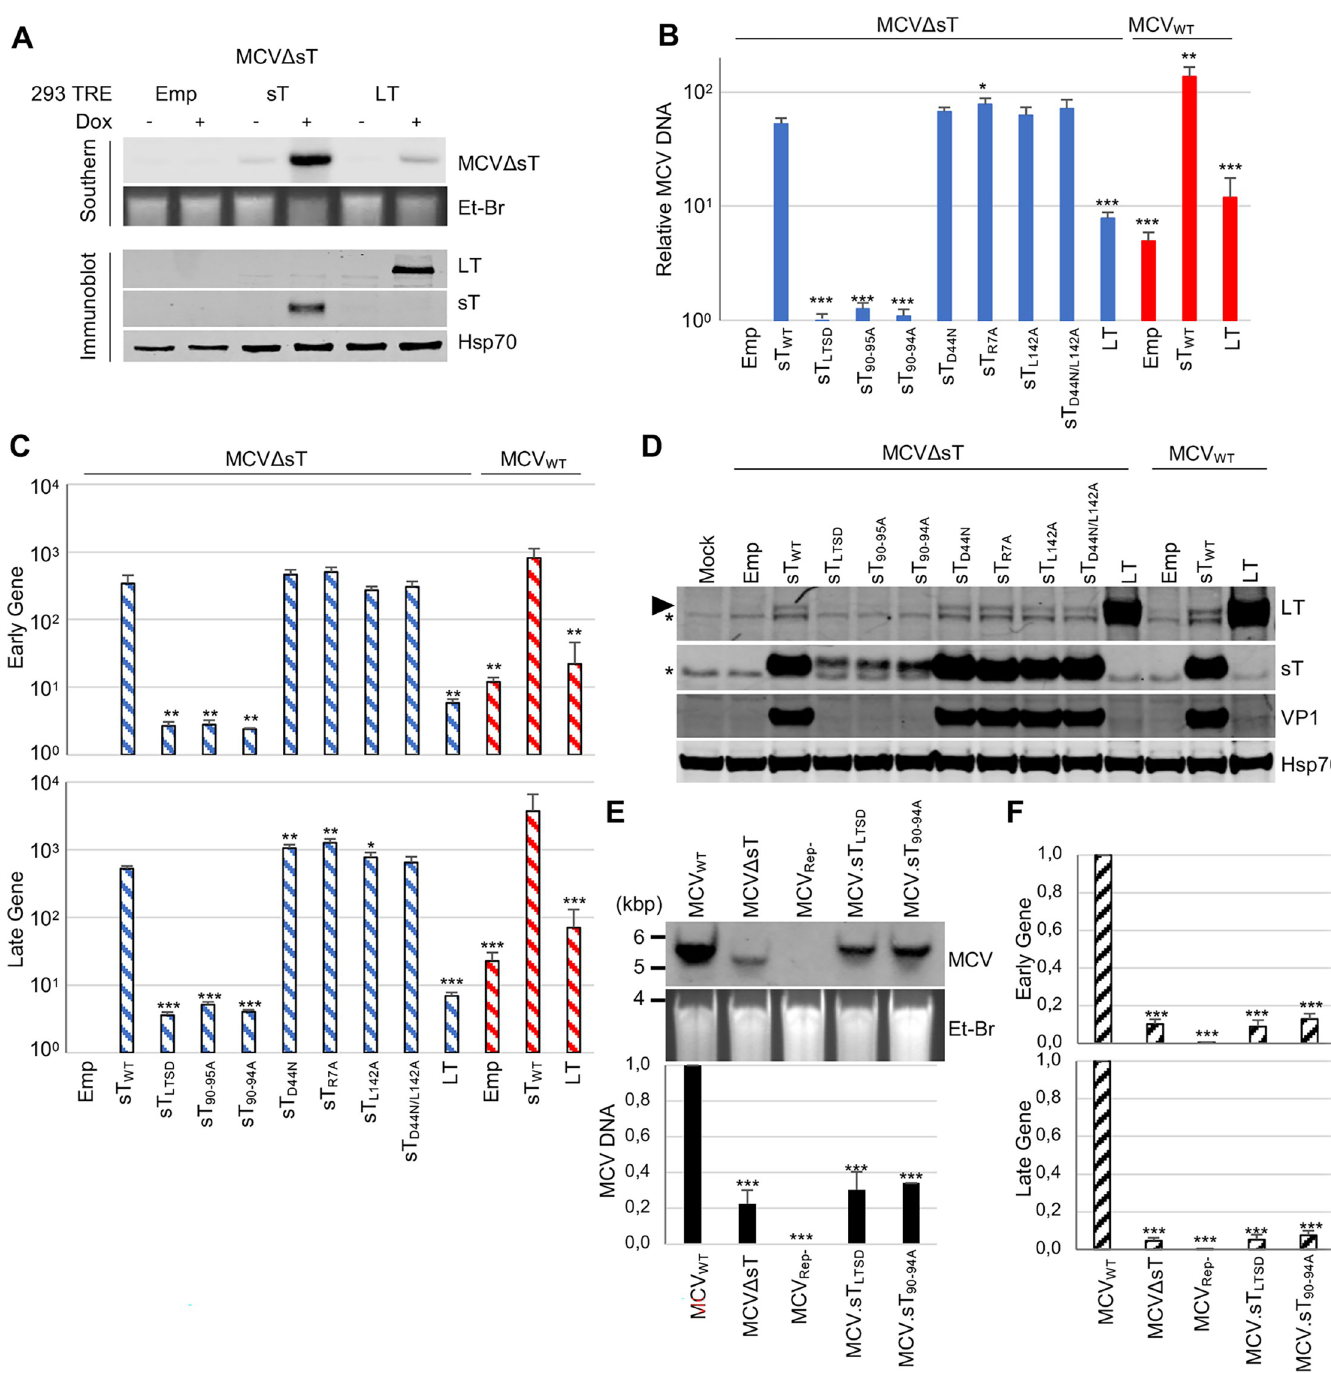
Fig 3. Mapping of sT domain required for viral genome maintenance. (A) MCV Δ sT DNA was transfected into 293 TRE-Emp, sT, and LT cells and harvested at day 6 p.t.. gDNA was digested with EcoRI and DpnI and run on a Southern blot showing the effect of exogenous pcDNA sT and LT on MCV Δ sT DNA replication. Immunoblot shown below was performed to confirm expression of exogenous sT and LT levels. (B-D) 293 cells were co-transfected with MCV WT (red) or MCV Δ sT (blue) and various pcDNA6 sT mutants including pcDNA Empty (Emp). Cells were then harvested at day 4 p.t.. (B) qPCR was performed as described in Fig 2A legend. To determine the effect of sT, sT mutants, and LT on MCV Δ sT and MCV WT replication, MCV DNA levels, relative to the control sample (MCV Δ sT co-transfected with pcDNA Empty), were analyzed by 2 - ΔΔ Ct method. Solid bar graphs represent viral DNA. Unpaired T-test was used for statistical analysis. Significance was determined in comparison to MCV Δ sT co-transfected with pcDNA6 sT WT . � , P < 0.05; �� , P < 0.01; ��� , P < 0.001. (C) RNA was extracted and converted to cDNA for qRT-PCR analysis to determine early and late gene expression as described in Fig 2B legend. Relative early and late mRNA expression to the same control in Fig 3B was determined by the 2 - ΔΔ Ct method. Hatched bar graphs represent viral mRNA expression. (D) Corresponding protein levels shown on an immunoblot stained with MCV proteins (LT, sT,